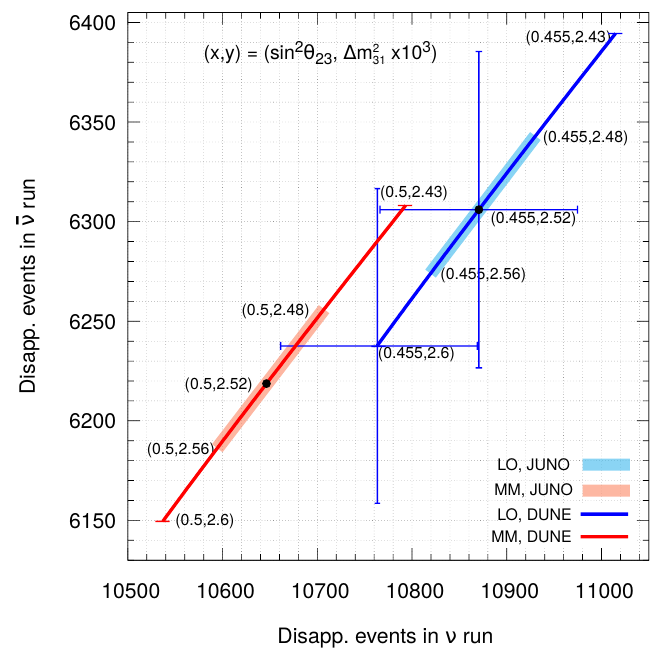
Figure 4 . Bi-events plot for DUNE in the plane of neutrino-antineutrino disappearance events assuming 336 kt · MW · years of exposure equally divided in neutrino and antineutrino modes. The blue line is obtained by varying ∆ m 2 in its 3 σ range of [2 . 43 : 2 . 6] × 10 − 3 eV 2 with sin 2 θ = 0 . 455 23 31 (LO). The red line depicts the same with sin 2 θ = 0 . 5 (MM). The black dot on each line shows 23 the disappearance events corresponding to the best-fit value of ∆ m 2 = 2 . 52 × 10 − 3 eV 2 . The values 31 of other oscillation parameters are taken from table 1 assuming NMO. The blue (red) rectangular region on blue (red) line portrays the variation in event rates due to 3 σ range in ∆ m 2 expected 31 from JUNO [101, 102]. The horizontal (vertical) error bars for the points [( sin 2 θ = 0 . 455 , ∆ m 2 = 23 31 2 . 52 × 10 − 3 eV 2 ) and ( sin 2 θ = 0 . 455 , ∆ m 2 = 2 . 6 × 10 − 3 eV 2 )] show the 1 σ statistical uncertainties 23 31 which are obtained by taking the square root of the ν (¯ ν ) disappearance